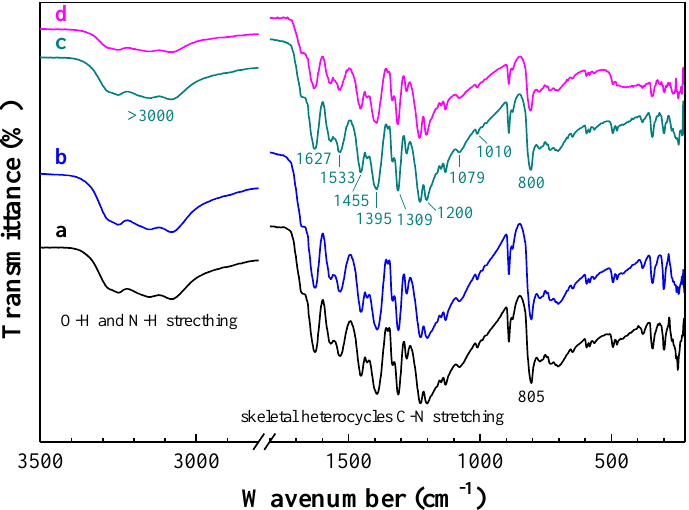
Figure 2. ATR-FTIR spectra of: ( a ) pristine g-C 3 N 4 , ( b ) protonated g-C 3 N 4 , ( c ) hydroxylaminated g-C 3 N 4 , and ( d ) hydrazinated g-C 3 N 4 .